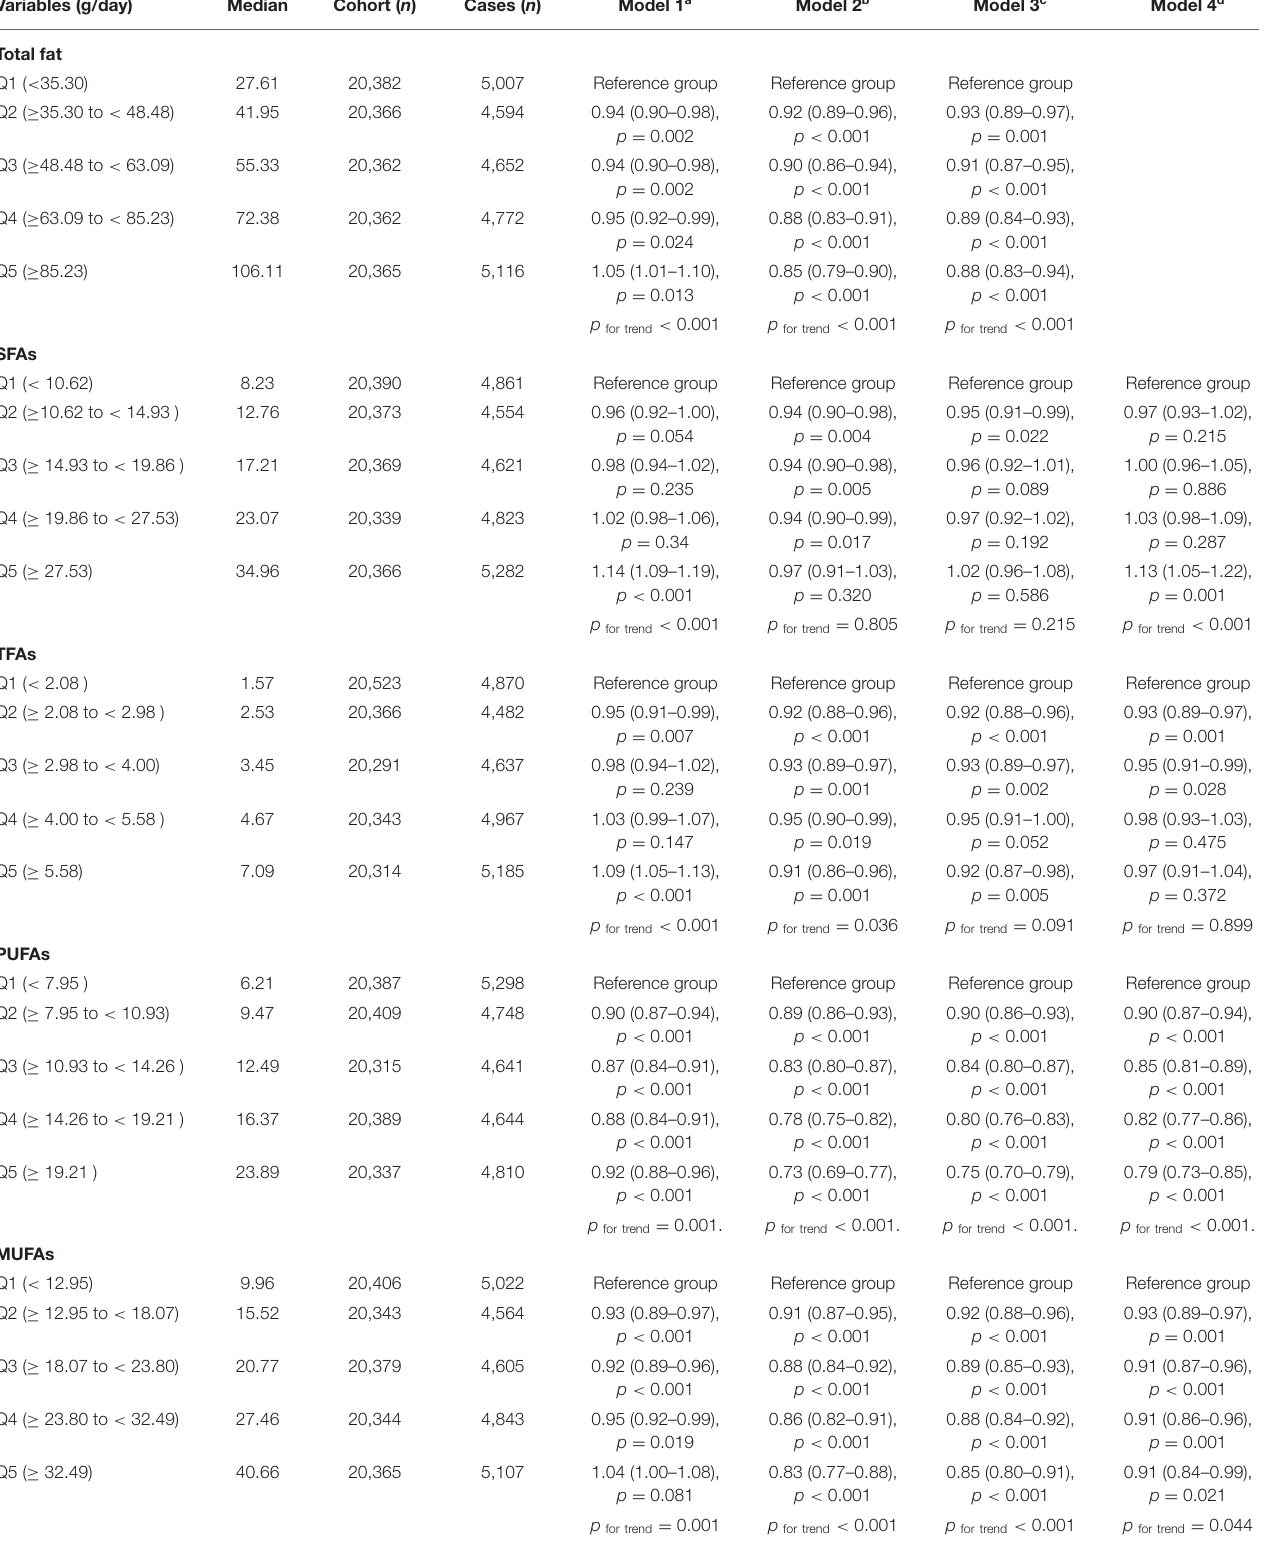
TABLE 2 | Associations of total and specific dietary fat intake with all-cause